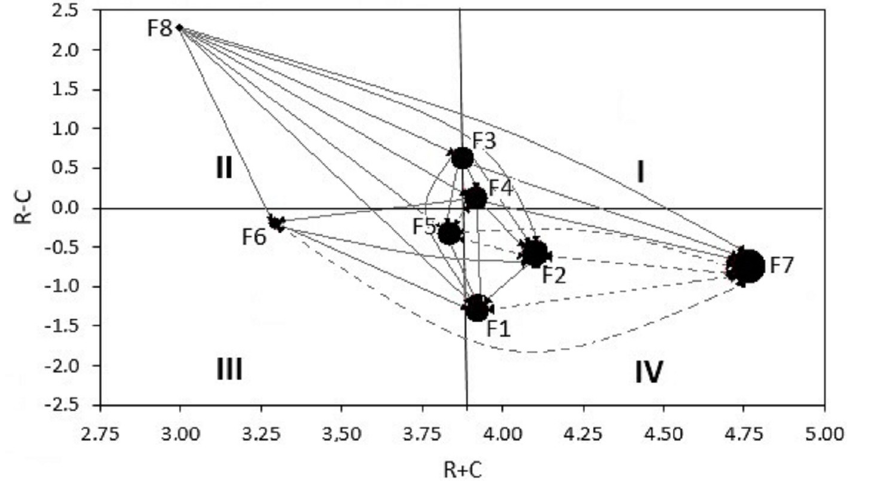
Fig 5. Influential relation map (IRM) of the factors (mean of R+C =